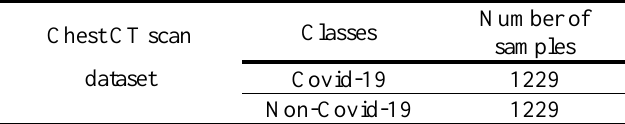
Table 1. Chest CT scan dataset